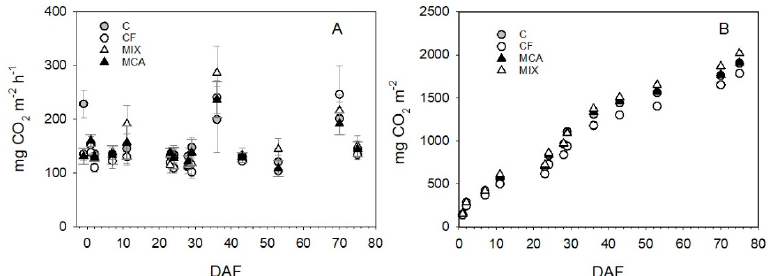
higher in the MIX compared with the control and 15% higher in CF and MCA treatments compared with control (no statistical difference, p > 0.05). Figure 2. Soil CO 2 hourly emission (A) and cumulative flux (B) measured in the plots of the four treatments between 13 May and 25 July 2013. DAF stands for days after fertilization event (13 May 2013). Error bars represent one standard deviation (n = 12) Average N 2 O fluxes were quite low, varying between 1.4 and 34.4 μ g N 2 O m -2 h -1